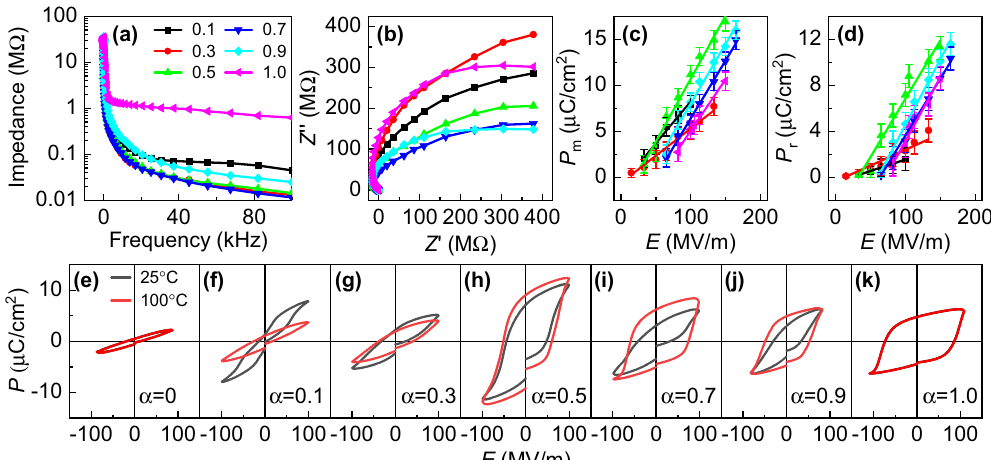
Fig. 3 Dielectric properties and polarization electric fi eld (P-E) hysteresis loop comparison. a Impedance graph. b Cole-Cole graph. c Maximum polarization ( Pm ) vs electric fi eld E (MVm − 1 ) graph. d Remnant polarization ( Pr ) vs electric fi eld E (MVm − 1 ) graph. e – k PE comparison graphs of α = 0, 0.1, 0.3, 0.5, 0.7, 0.9, and 1.0 blend respectively. Error bars: a , b , c , d = standard deviation ( n = 6), e , f , g , h , i , j , k = standard deviation ( n =